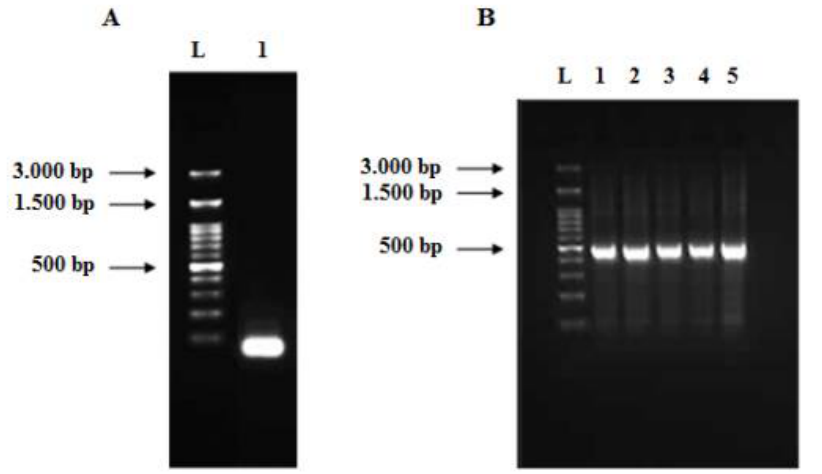
Figure 3. Positions of oligonucleotides used in human TNF-α synthetic gene assembly indicated by arrows. Gaps in between the designed oligonucleotides are in red color. Table 2. Sequences of human TNF-α gene-specific primers.